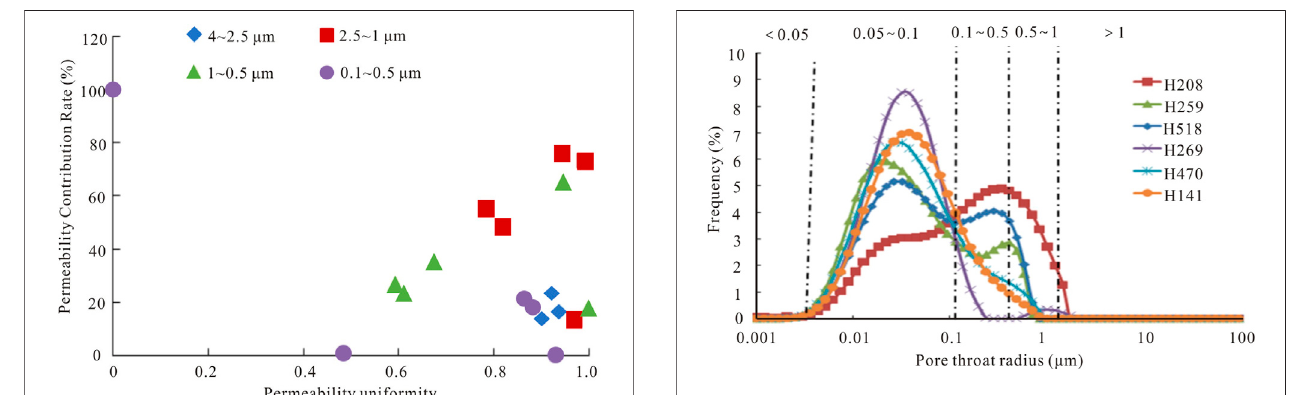
FIGURE 9 | Distribution frequencies of the pore-throat radius of the